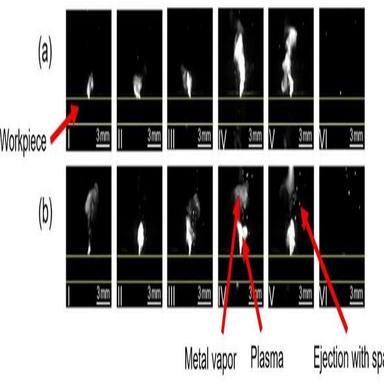
High-speed camera images showing the transient evolution of the through-hole drilling stage using the second laser pulse (a) without and (b) with waterbased ultrasonic assistance.